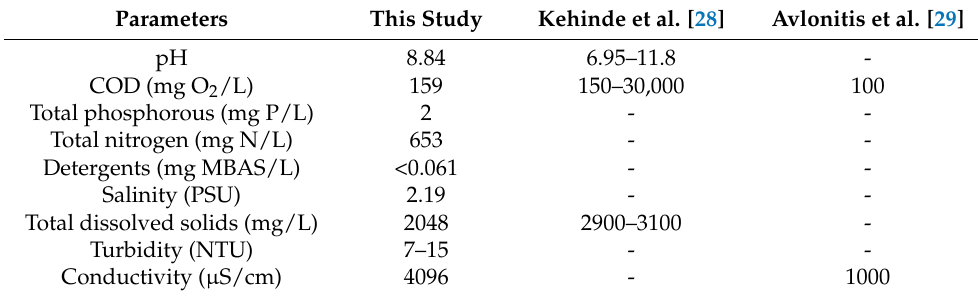
Table 1. Main parameters of TW and comparison with reported values.